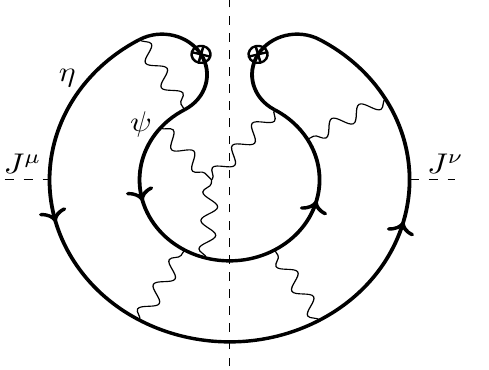
Figure 2 . The same graph as figure 1, with insertion of h ψη i condensates (shown with ⊗ ). The intermediate state now corresponds to the U(1) NG boson ∼ ψη of eq. (2.40). (see eq. (3.42) for the exact meaning) implies the condensation of the component